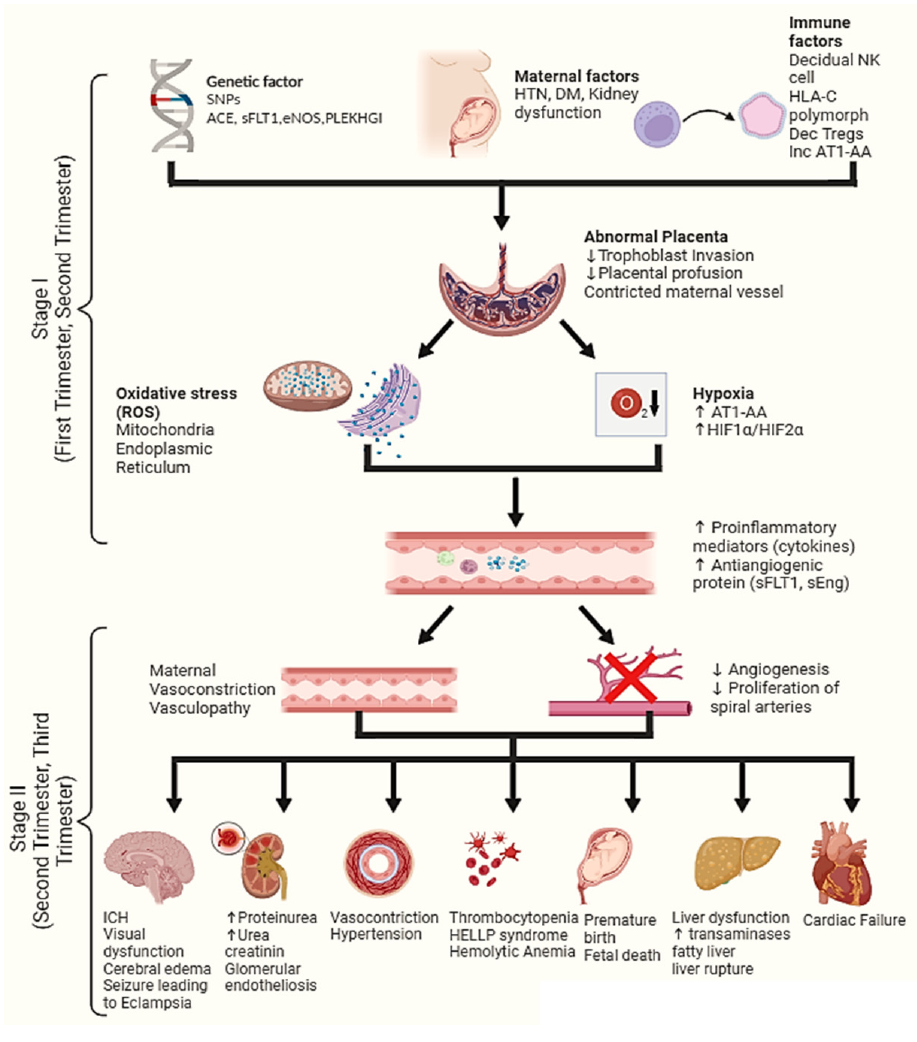
Figure 1. Stages of the pathogenesis of pre-eclampsia. Stage I shows factors such as genetic, maternal, and immune factors that are responsible for abnormal placental formation. This leads to hypoxia and high oxidative stress, which causes the release of proinflammatory mediators and antiangiogenic factors, causing multiple organ failure, eclampsia, premature birth, or fetal death. In stage II, maternal vasoconstriction, vasculopathy, decreased angiogenesis, and a decrease in spiral artery proliferation led to multiorgan failure. Abbreviations |SNP: single-nucleotide polymorphism; sFLT1: soluble FMS-like tyrosine kinase-1; eNOS: endothelial nitric acid synthase; ACE: angiotensin-converting enzymes; PLEKHG1: pleckstrin homology and RHOGEF domain containing G1; HTN: hypertension, DM: diabetes mellitus; NK cell: natural killer cell; HLA-C: human leukocyte antigen-C, AT1-AA: angiotensin I and II autoantibodies; Tregs: regulatory T cell; HIF1 α : hypoxia-inducible factor 1 alpha; HIF2 α : hypoxia-inducible factor 2 alpha; ROS: reactive oxygen species; ICH: intracerebral hemorrhage; sEng: